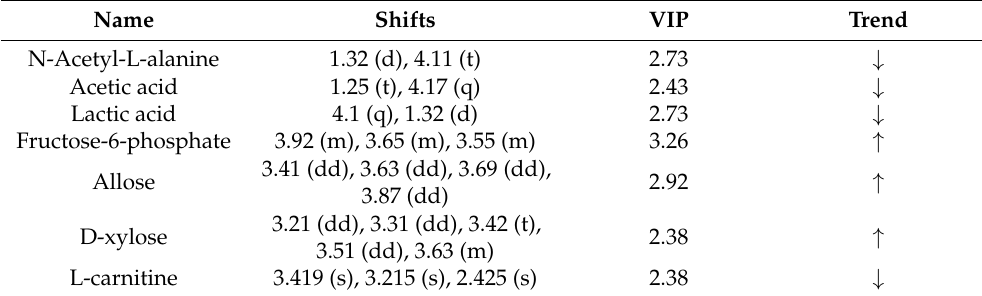
Table 3. Differently expressed metabolites in the PM group compared with the DSS group.